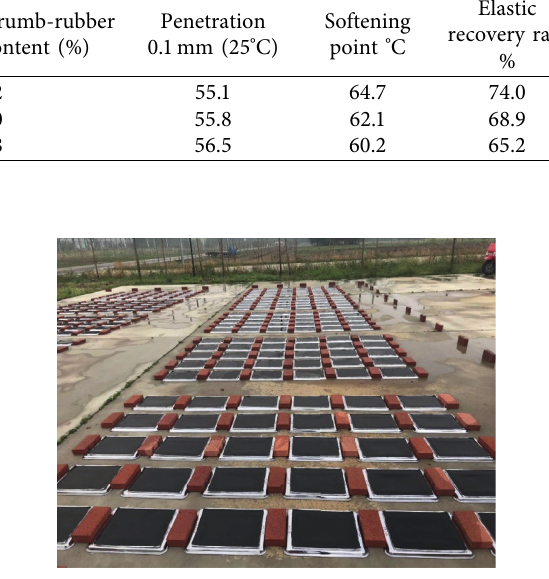
Figure 1: Aging environment conditions of natural weathering.